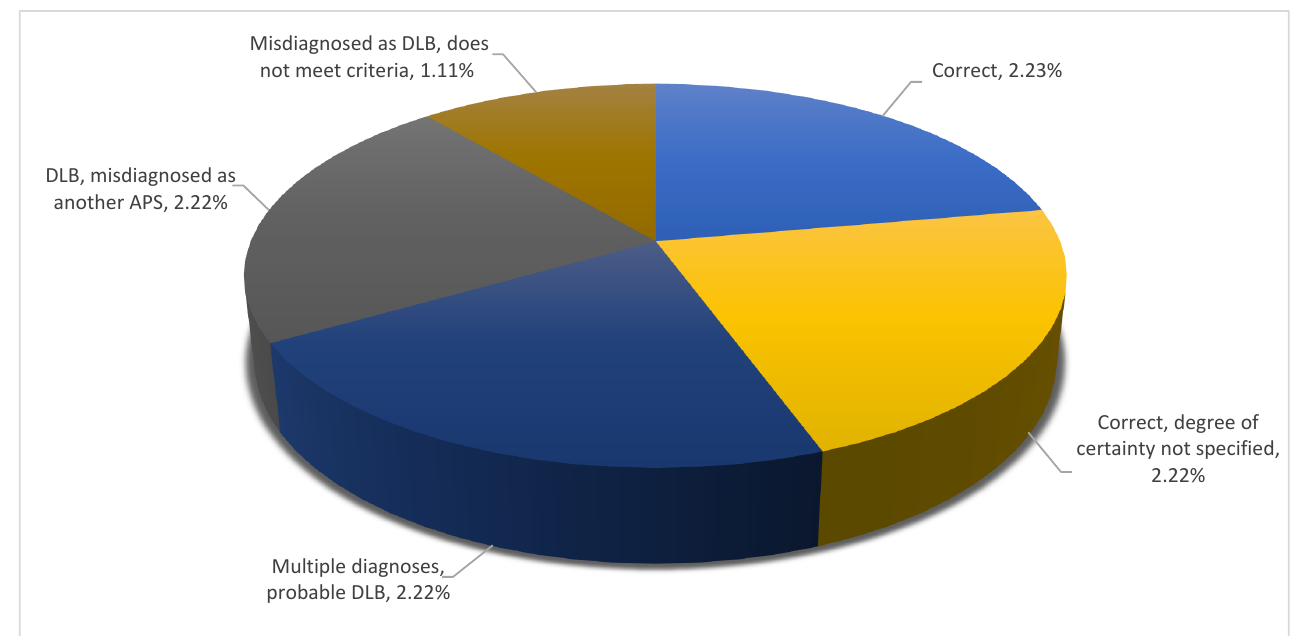
Figure 6. Diagnostic precision per type of atypical parkinsonism: DLB.